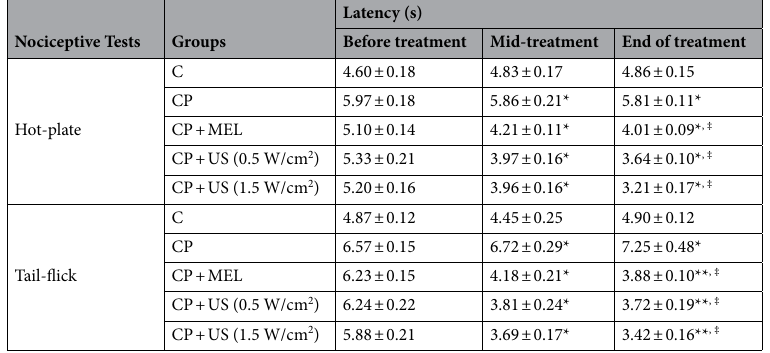
Table 2. Results of the nociceptive tests recorded as latency (s) of a reaction given in response to thermal painful stimuli during the 15-day treatment period. The data were represented as mean ± standard error of mean. Differences in between variances were compared by One-way ANOVA test with Tukey’s test applied as a post-hoc test. P -values equal or less than 0.05 were considered as statistically significant (* p < 0.05, ** p < 0.01, *** p < 0.001). The degree of significance was symbolized by an asterisks (*) for the comparison of all groups with respect to the control group; by a double daggers (‡) for the comparison of the treatment groups with respect to the cisplatin administered group; by a daggers (†) for the comparison of ultrasound treated groups with respect to the melatonin administered group and by a section (§) for the comparison of 1 MHz 1.5 W/cm 2 US treated group with respect to the 1 MHz 0.5 W/cm 2 US treated group.